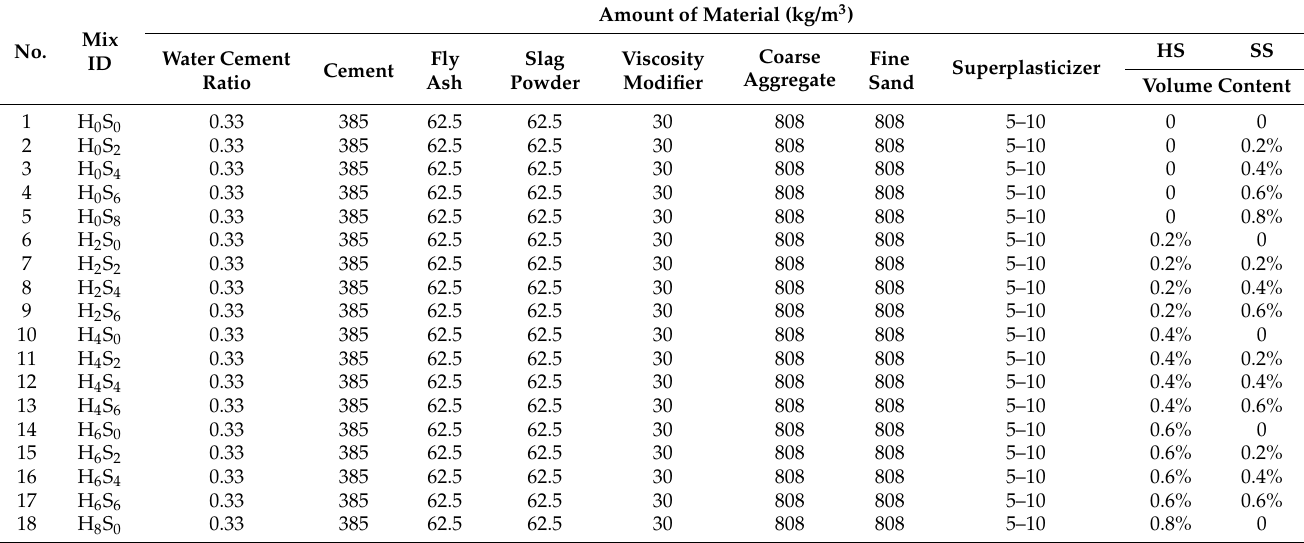
Table 2. Mixture of single or hybrid steel fiber self-compacting